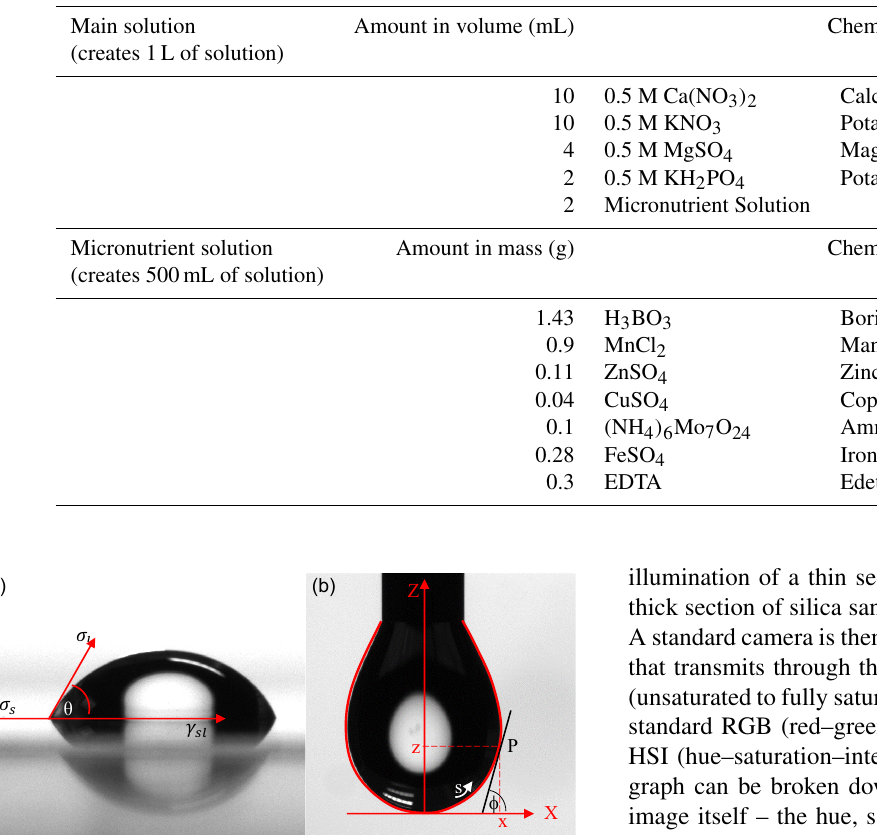
Table 1. Composition of Hoagland nutrient solution; recipe followed from Arnon and Hoagland (1940).